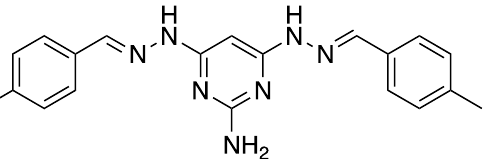
Figure 1. Chemical structure of novel pyrimidine NCL195, 4,6-bis(2-(( E )-4- methylbenzylidene)hydrazinyl)pyrimidin-2-amine.